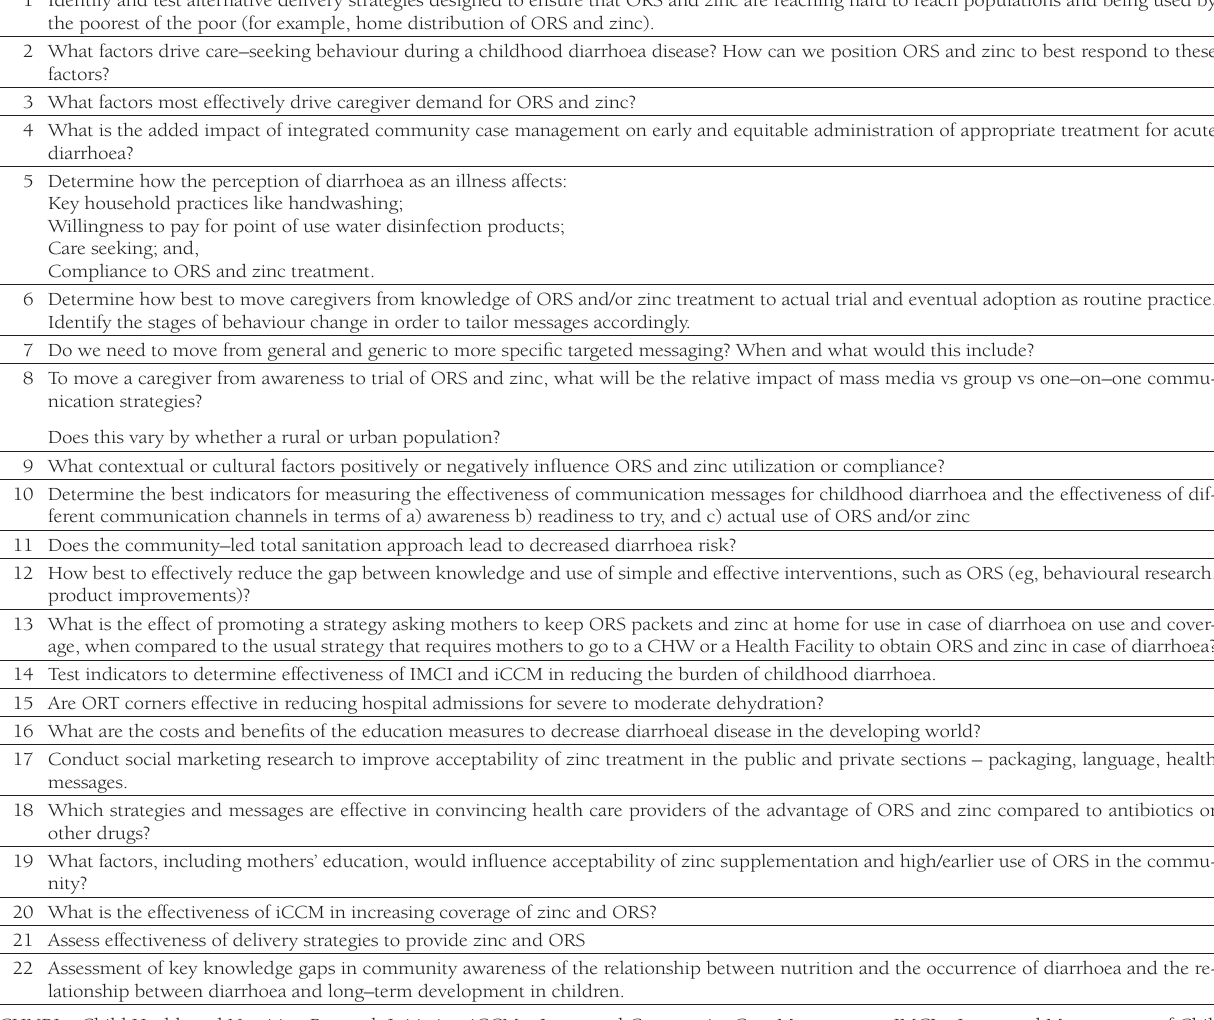
Table 4. Delivery–related questions identified by the CHNRI